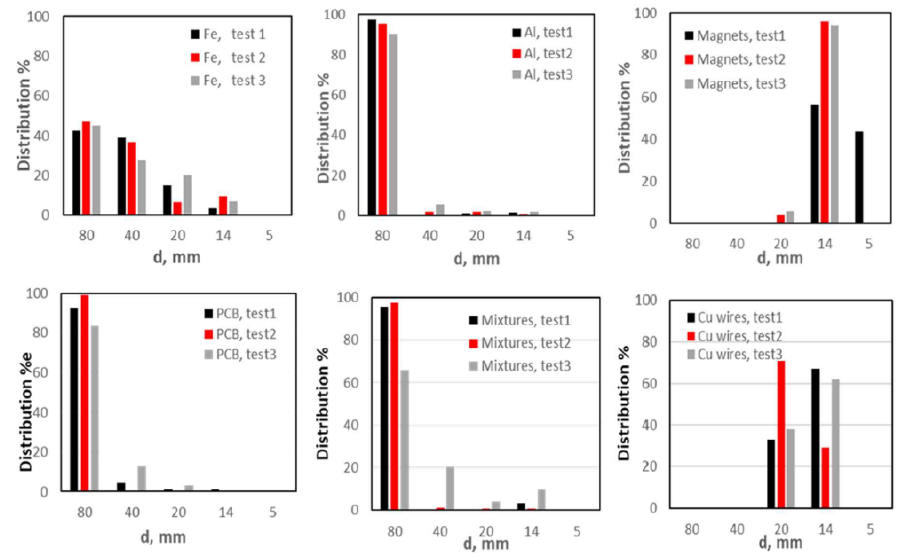
Figure 6. Percentage distribution of hard drive materials manually sorted into 80-, 40-, 20-, 14-, and 5-mm size fractions obtained from the three pilot tests.